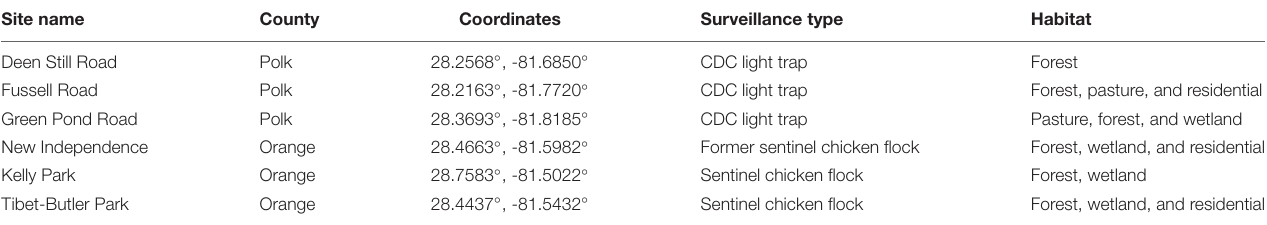
TABLE 1 | Mosquito sampling location details. Orange and Polk County, FL, in 2018.